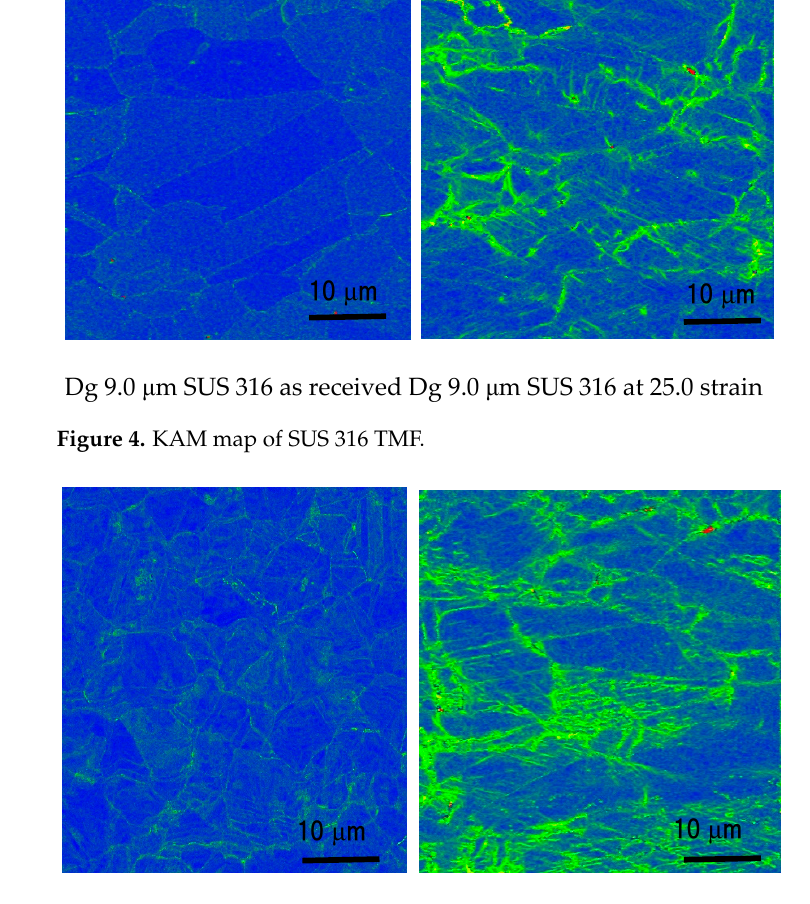
Figure 5. KAM map of SUS 304 TMF.